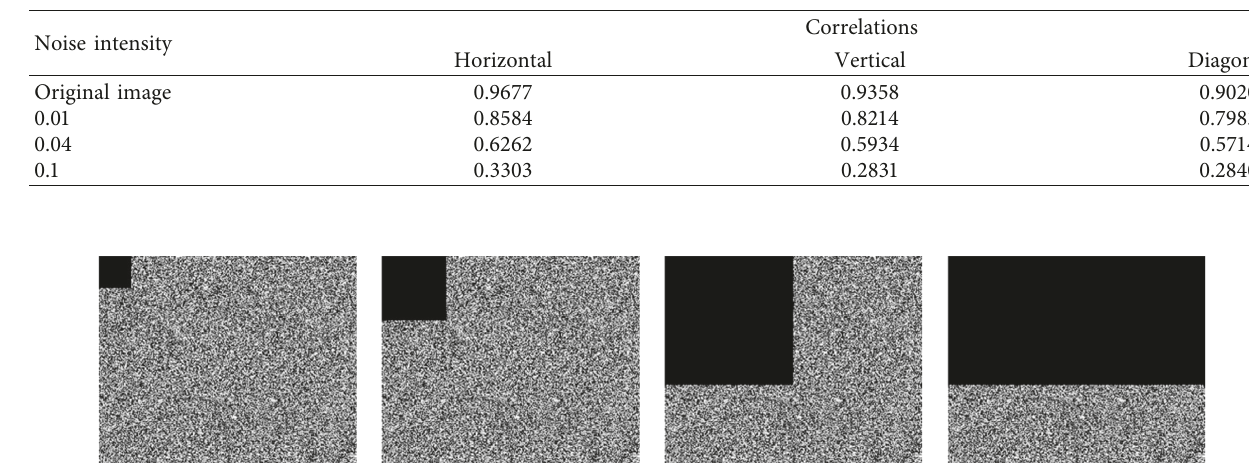
Figure 10: Decrypted images with different intensities of noise attacks. Noise intensity (a) of 0.01, (b) 0.04, and (c) 0.1; decrypted image with (d) 0.01 intensity noise, (e) 0.04 intensity noise, and (f) 0.1 intensity noise. Table 6: Correlations of decrypted images with different intensities of noise attack.